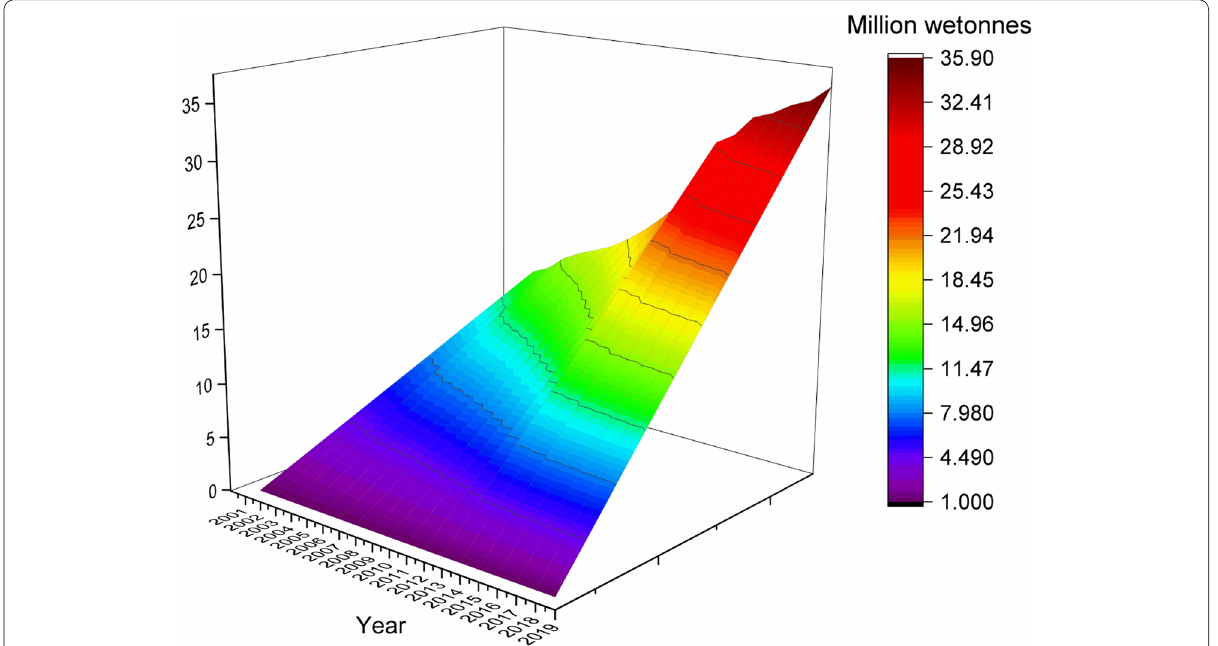
Fig. 1 Status and trends of world algal production from 2001 to 2019 (FAO